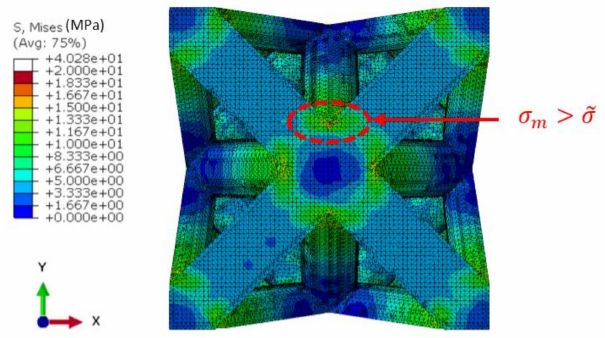
Figure 2. Von Mises stress field in an FCC lattice (x = 0.0 and y = 0.5), and stress concentration at nodes.